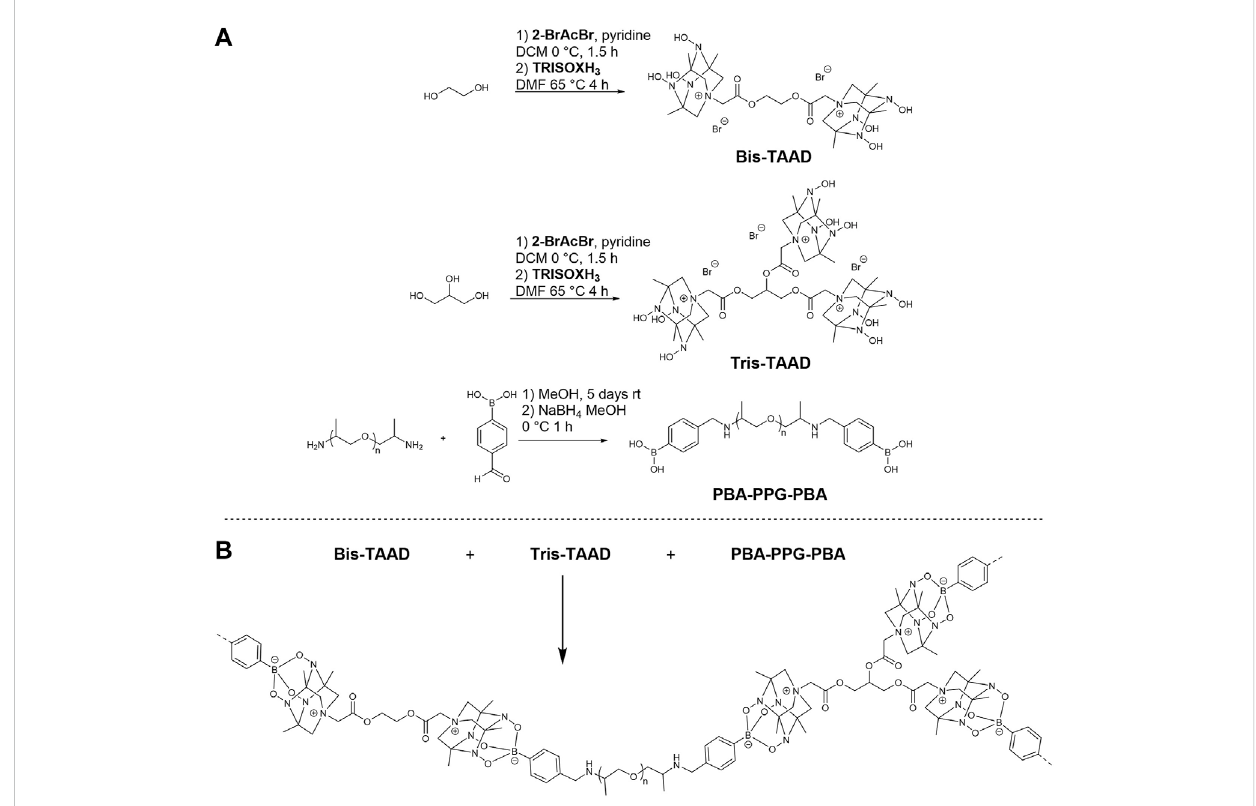
FIGURE 2 Synthesis and structure of the phenylboronic acid and TAAD linkers used in the boronate network (A) , and synthesis of the TAAD-based polymer networks (B) . For clarity, the counter anions have been omitted in the bottom fi